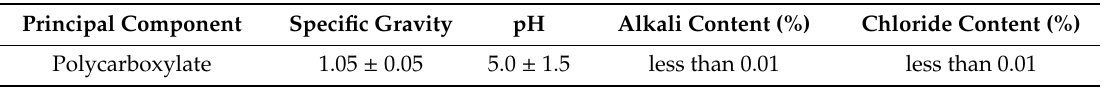
Table 5. Properties of polycarboxylate high range water reducer